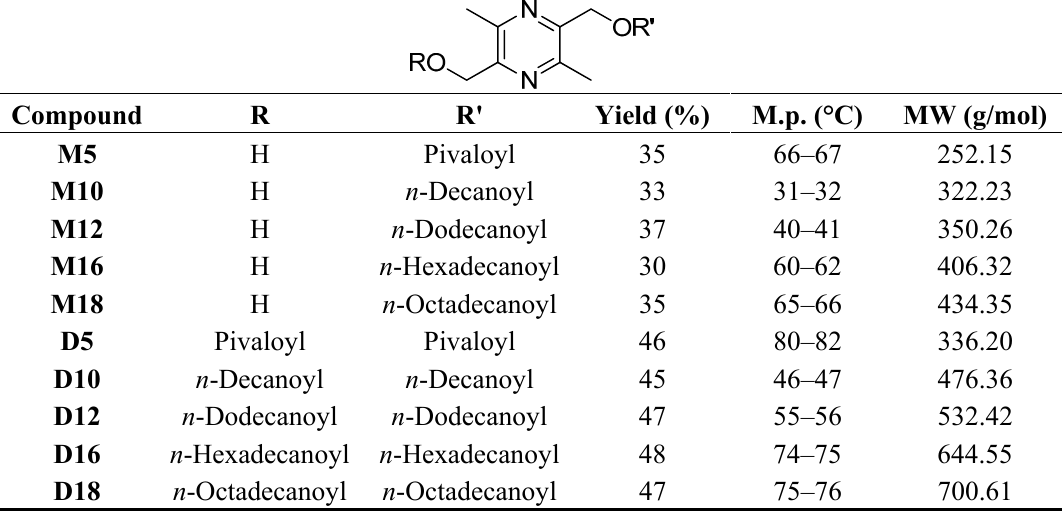
Table 1. Structure; Yield; Melting Point; and Molecular Weight of